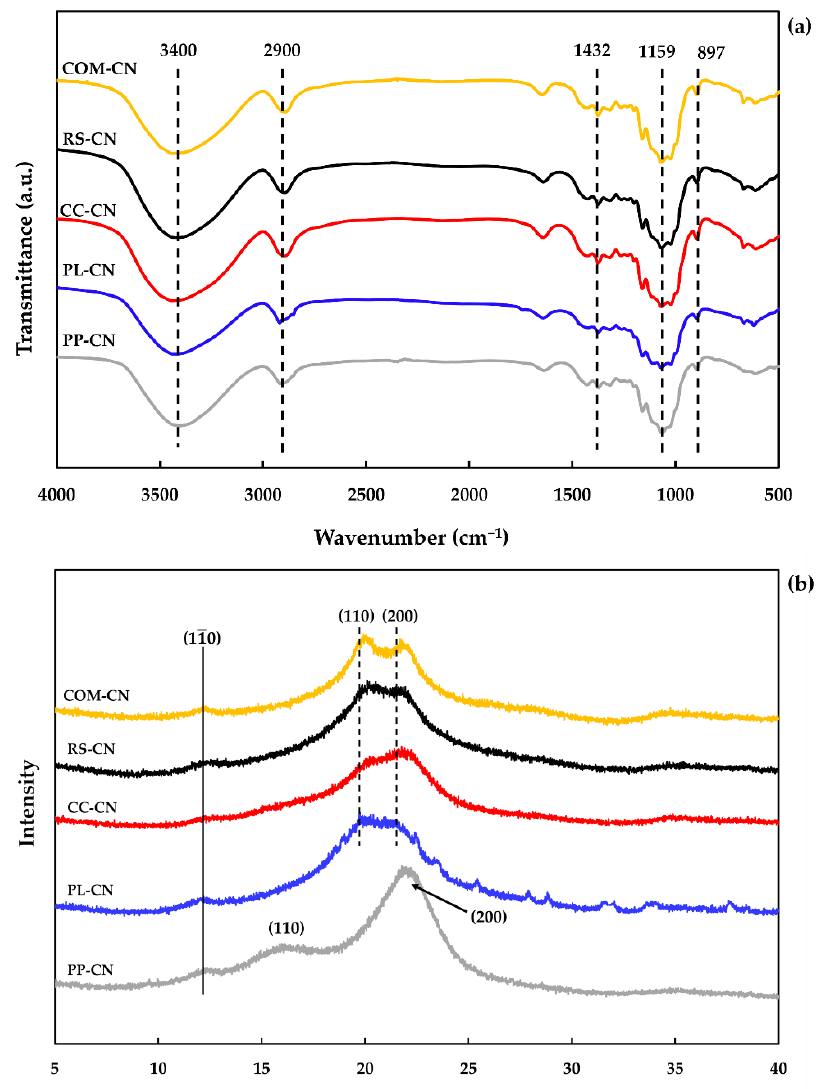
Figure 2. FTIR spectra ( a ) and XRD spectra ( b ) of cellulose nanosphere isolated from different sources compared with commercial cellulose . RS - CN : rice straw cellulose nanosphere; CC - CN : corncob cellulose nanosphere; PL - CN : pineapple leaves cellulose nanosphere; PP - CN : pineapple peels cellulose nanosphere; COM - CN : cellulose nanosphere hydrolyzed from commercial cellulose .